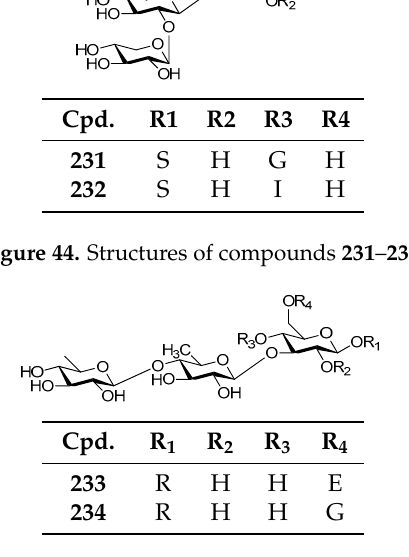
Figure 43. Structure of compound 230.